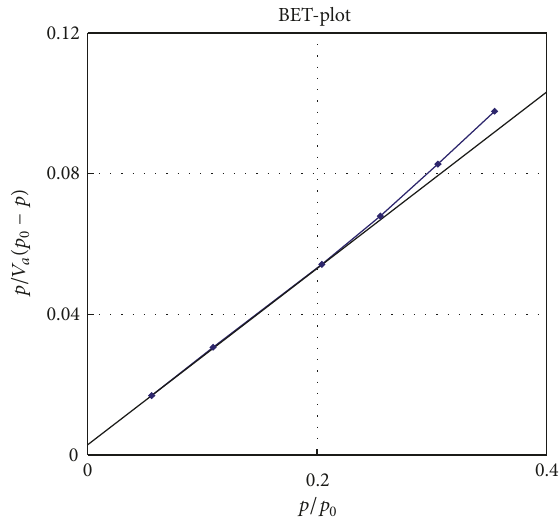
Figure 7: BET adsorption isotherm of the spherical biocarriers.